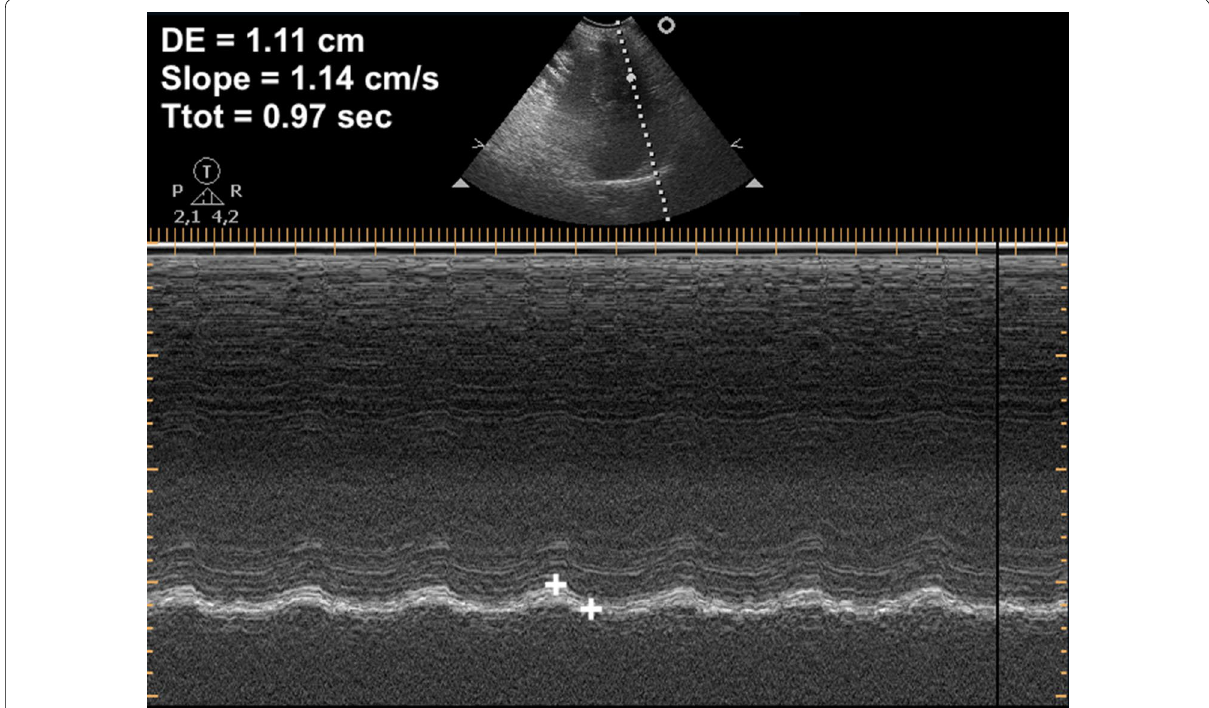
Fig. 4 Diaphragm excursion. DE diaphragmatic excursion, Slope diaphragmatic contraction speed, Ttot inspiration